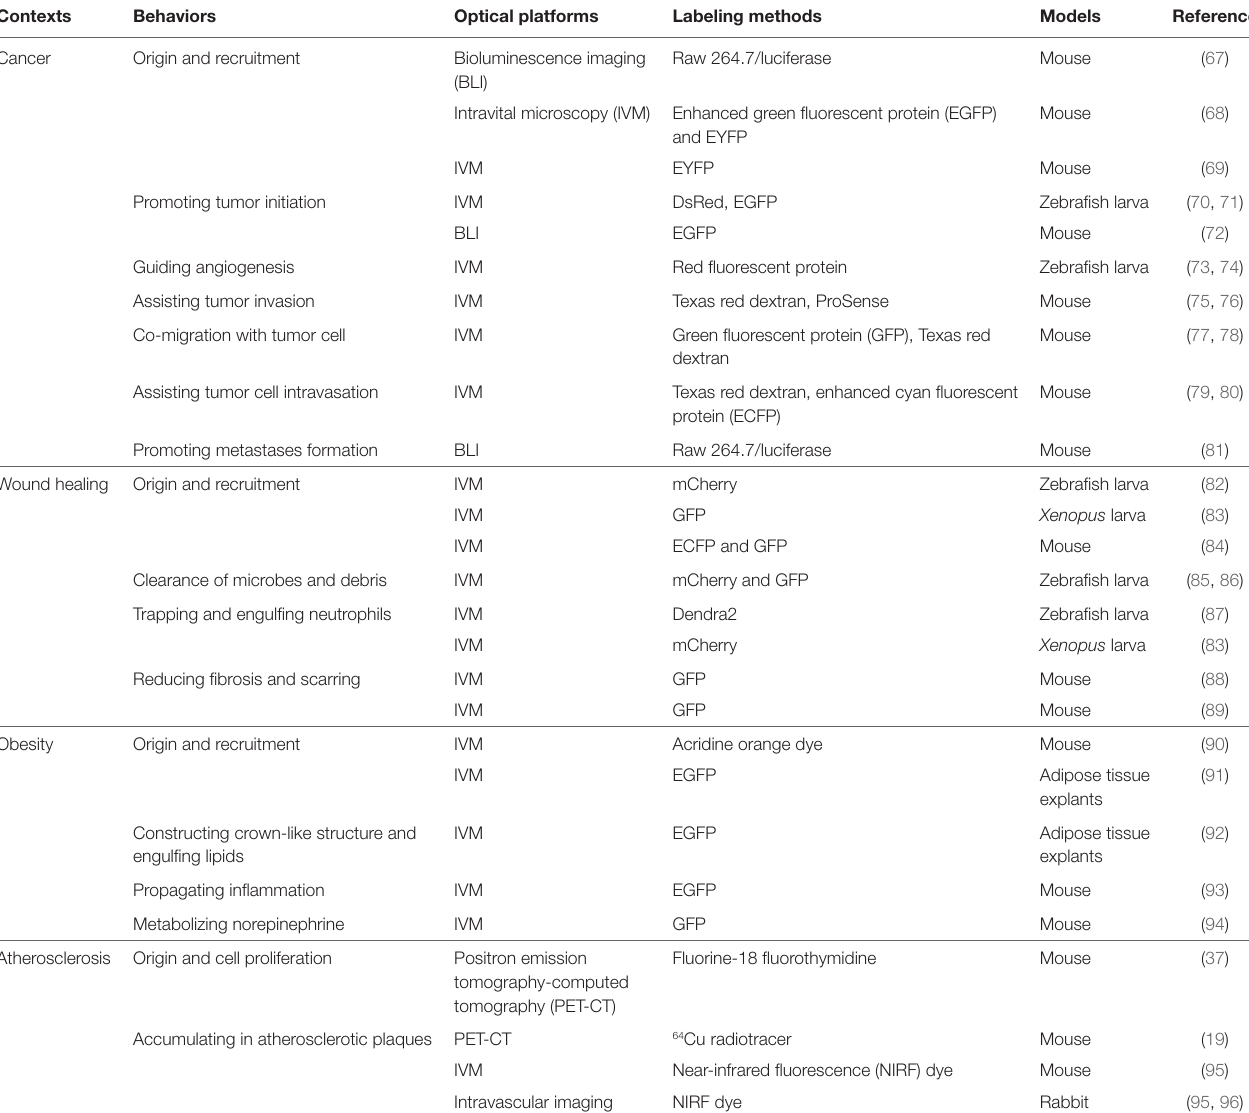
Table 2 | Imaging macrophages in the context of different